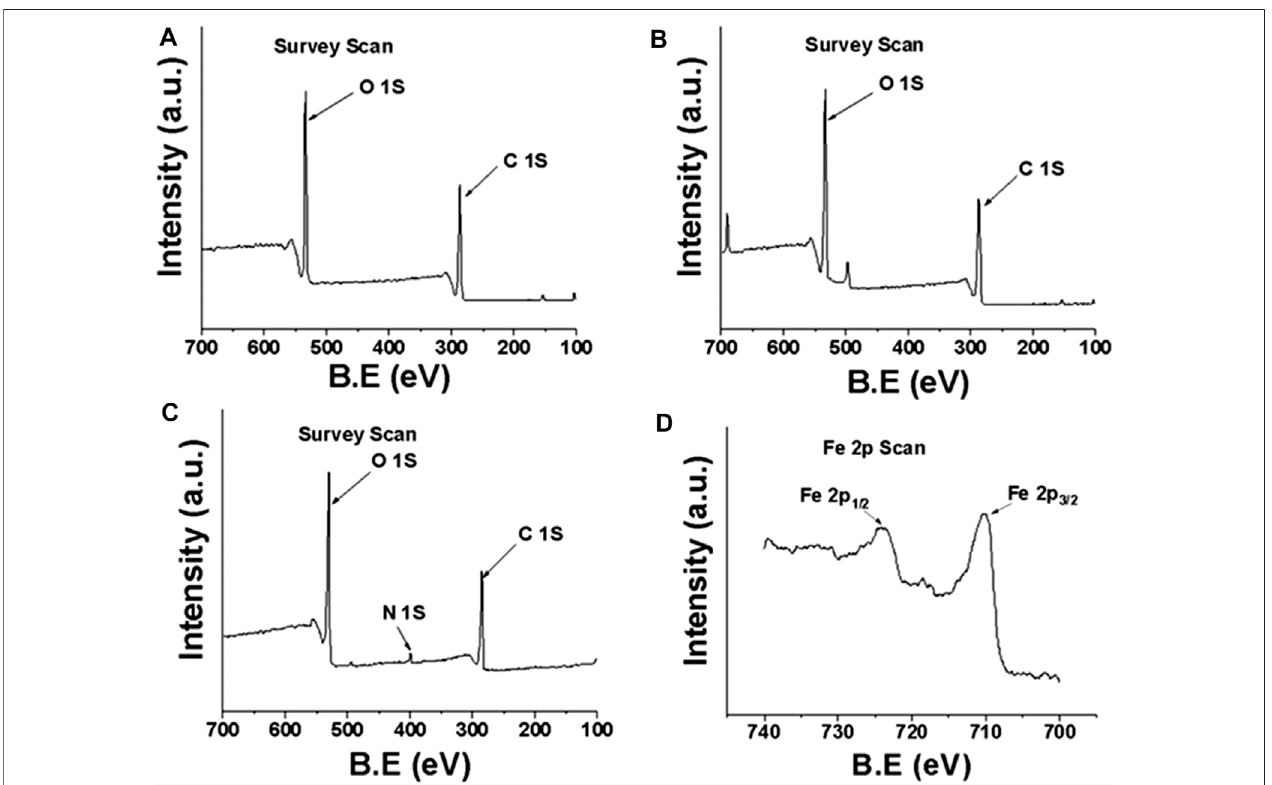
FIGURE 4 | XPS survey scan: (A) DP, (B) SA-DP, (C) MDP@PDA, and (D) Fe 2p XPS spectra of